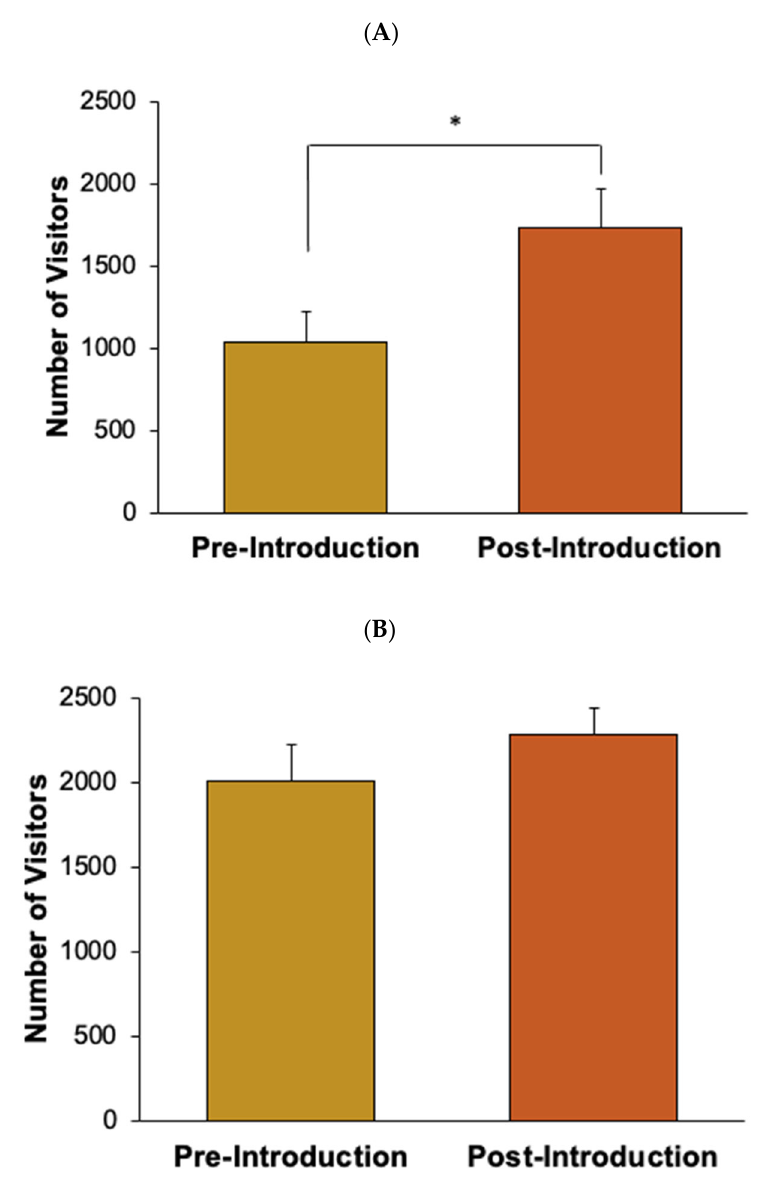
Figure 1. Average visitor attendance (with standard error of the mean bars) to the Seattle Aquarium during the times of observation, comparing pre- and post-introduction. ( A ) shows the mean number of visitors that attended the aquarium during Experiment 1, with standard error of the mean bars. ( B ) shows the mean number of visitors that attended the aquarium during Experiment 2, with standard error of the mean bars. Solid lines and asterisk represent statistically significant results ( p < 0.05).